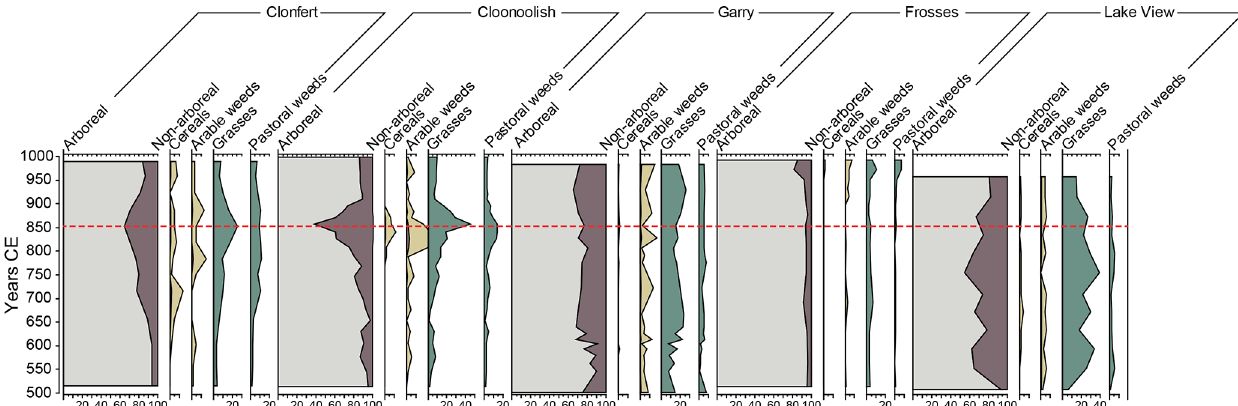
Figure 7. Summary pollen records from five sites in Ireland, showing the ratio of arboreal to non-arboreal (dryland) taxa and indicators of arable and pastoral environments. Cereal and arable weed curves are shown with a 10-fold exaggeration. The red dashed line indicates